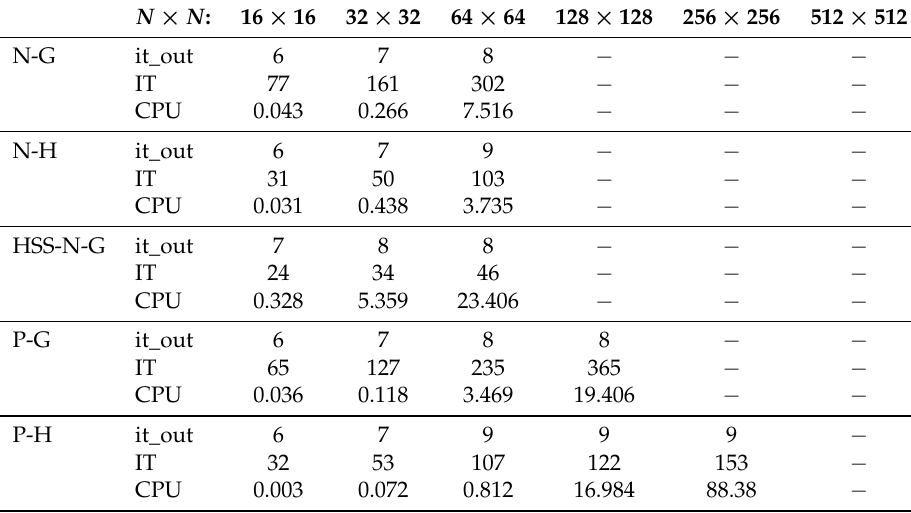
Table 8. Iteration counts and elapsed CPU time for Case 2.2